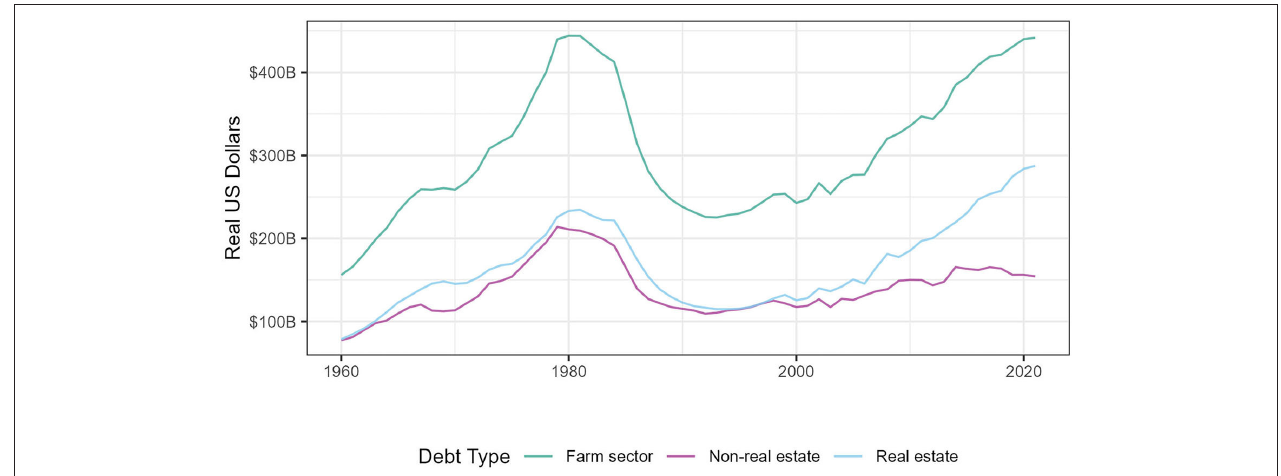
FIGURE 14 | Rising farm sector debt, adjusted for inflation using the chain-type GDP deflator provided by the USDA ERS. Farm sector debt is all debt (real estate and non-real estate) accrued by the agricultural sector. See Supplementary Figures 13, 14 for breakdown of non-real estate and real estate debt. Data: (USDA ERS, 2021b